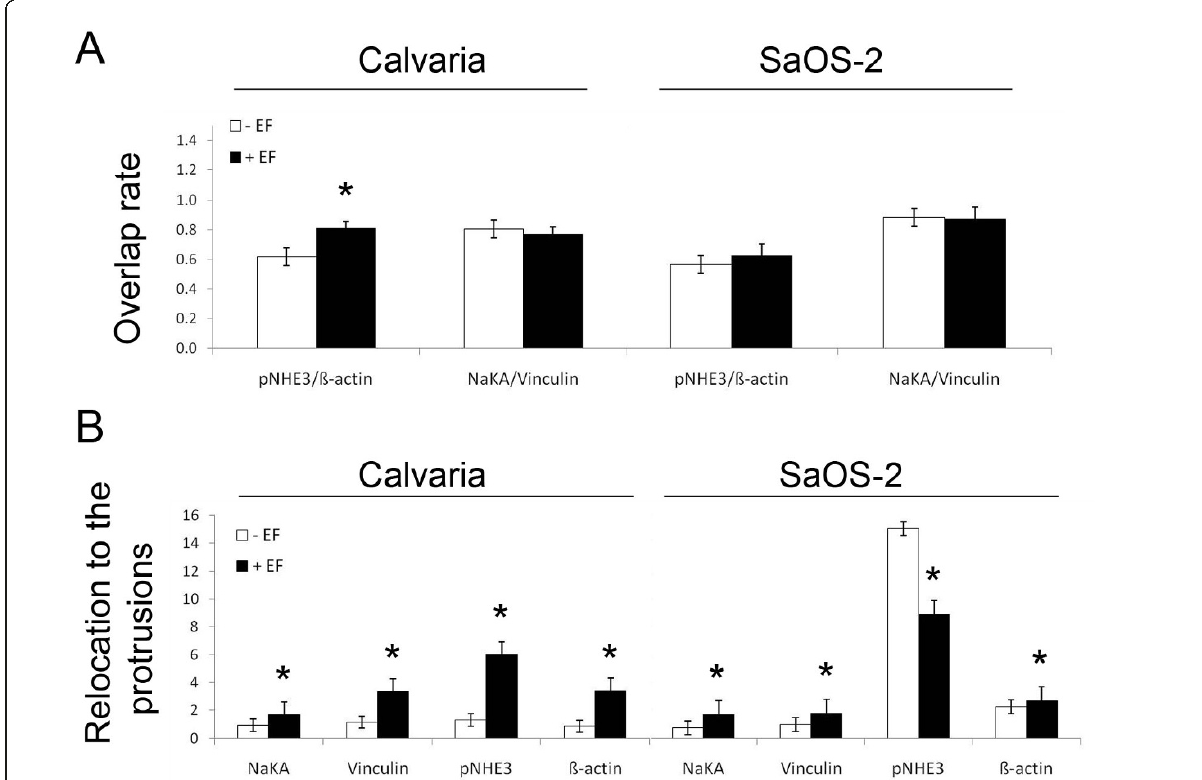
Figure 2 Graphics showing the colocalization rate and relocation of proteins during electrotaxis. The colocalization rates of pNHE3/ß- actin and of NaKA/vinculin with and without EF exposure in cathode (Calvaria)- and anode (SaOS-2)-directed cells (A). The EF-induced relocation of pNHE3, NaKA, ß-actin, and of vinculin to or from the leading edge of a cell during cathode (Calvaria)- and anode (SaOS-2)-directed motility (B). Error bars represent the SEM for 16-31 cells from three separate experiments (* P < 0.05 compared to the control -wothout